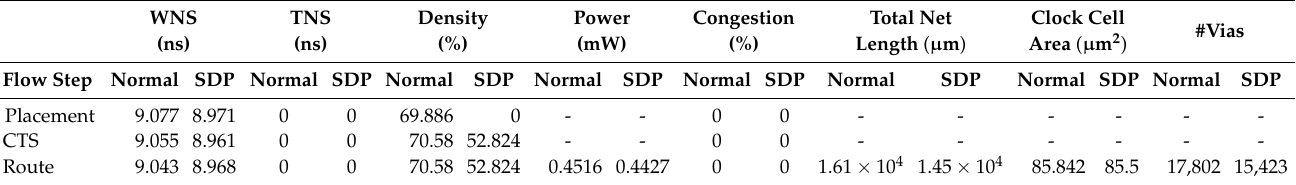
Table 2. Summary of Results for PB Design, Core Area W = 114.8 µ m, L = 107.73 µ